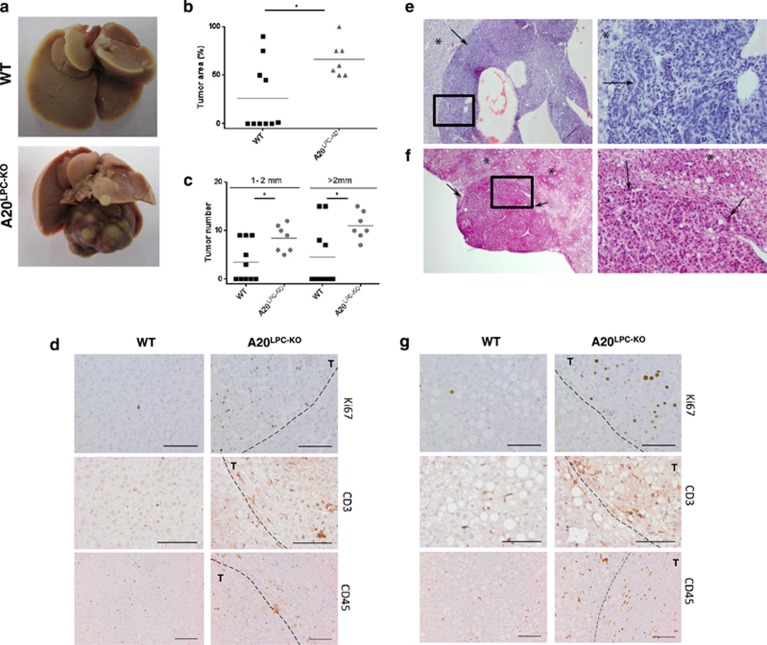
Hepatocyte-specific A20 deletion enhances susceptibility to chemically induced and HFD-induced hepatocarcinogenesis. (a-d) Female A20LPC-KO and control littermate mice (WT) were injected with DEN at day P15 and were sacrificed 70 weeks after DEN injection. (a) Representative pictures of livers from hepatocyte-specific A20 knockout (A20LPC-KO) and control WT littermate mice. (b) Percentage of tumor occupied liver area, and (c) numbers of tumors size 1-2 mm and>2 mm in livers. *,P<0.05. (D) Immunostaining for proliferating cells (Ki67) and infiltrating immune cells (CD3, CD45). Scale bar=100 μm. T, tumor area. (e-g) Male A20LPC-KO and control littermate mice (WT) were fed with an HFD for 1 year. Representative picture of a hepatoblastoma (arrows) recorded in HFD-A20LPC-KO mouse (e). Representative picture of a hepatocellular adenoma (arrows) recorded in HFD-A20LPC-KO mouse (f). Non-neoplastic tissue is depicted by asterisk. The right pictures are a higher magnification to the boxed areas. (g) Immunostaining for proliferating cells (Ki67) and infiltrating immune cells (CD3, CD45). Scale bar=100 μm. T, tumor area. DEN, diethylnitrosamin; HFD, high fat diet; WT, wild type